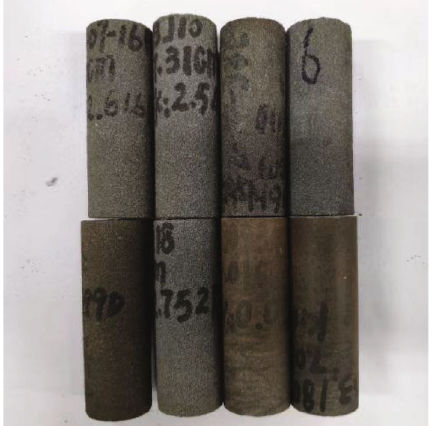
Figure 2: The analyzed drill core samples.